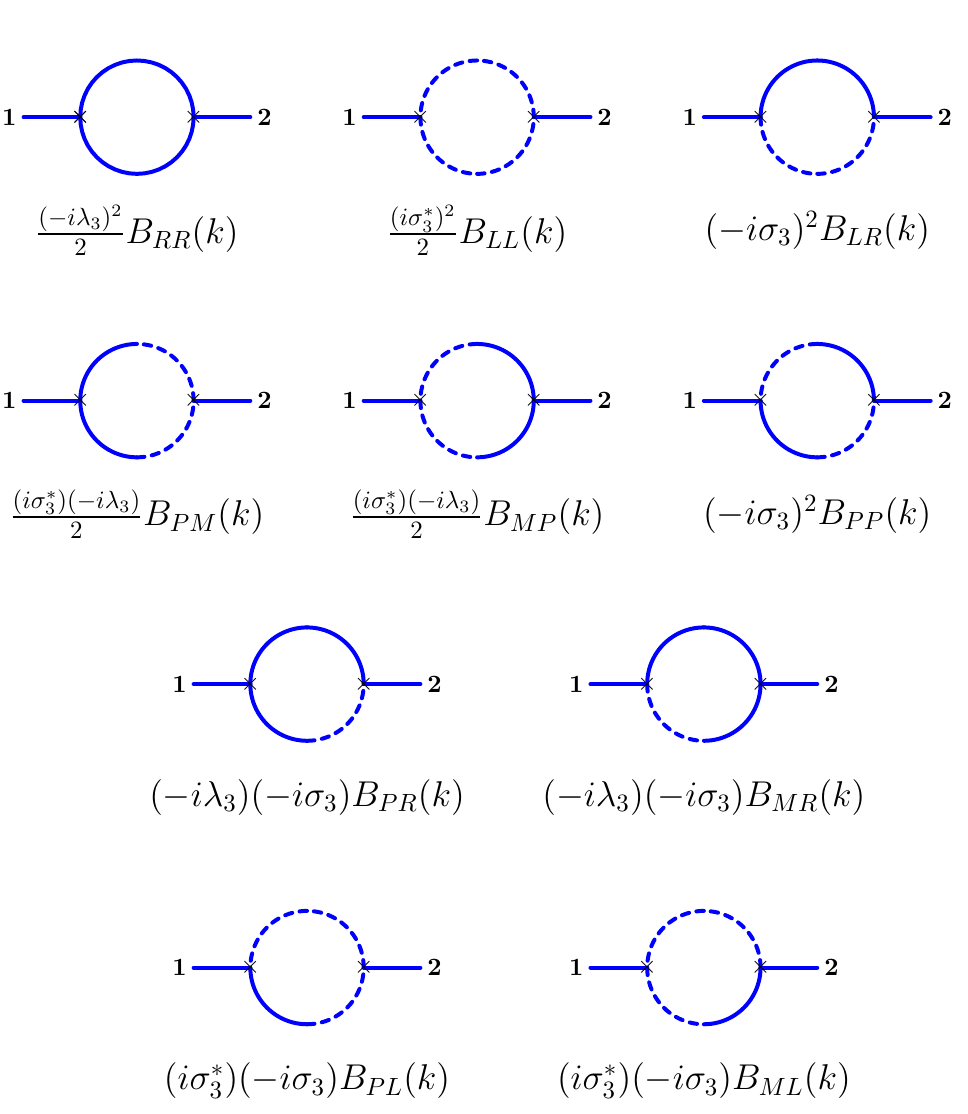
Figure 4. One Loop corrections to m 2 due to cubic